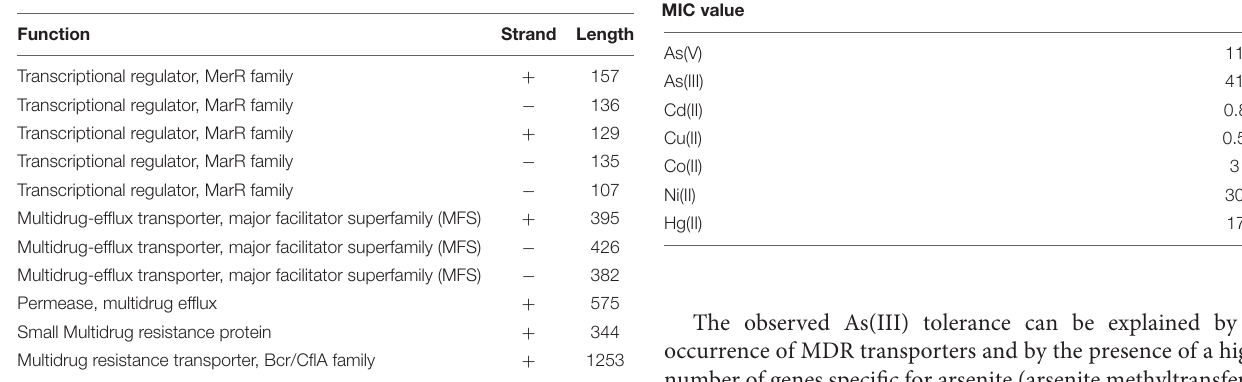
TABLE 5 | Annotation, strand, and length of the predicted heavy metal and/or antibiotic resistance genes.